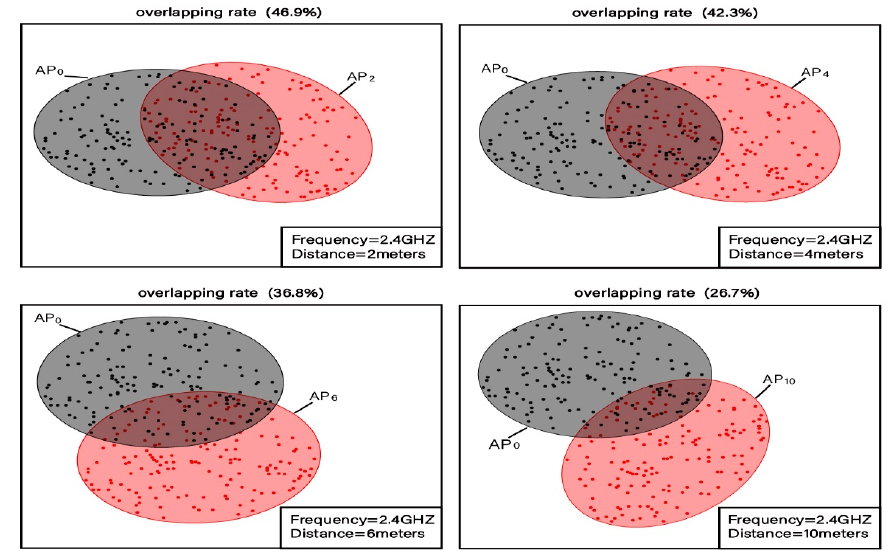
Figure 3. Distinguishability of 2.4G 2D fingerprint data clustering intervals of reference points at adjacent locations.